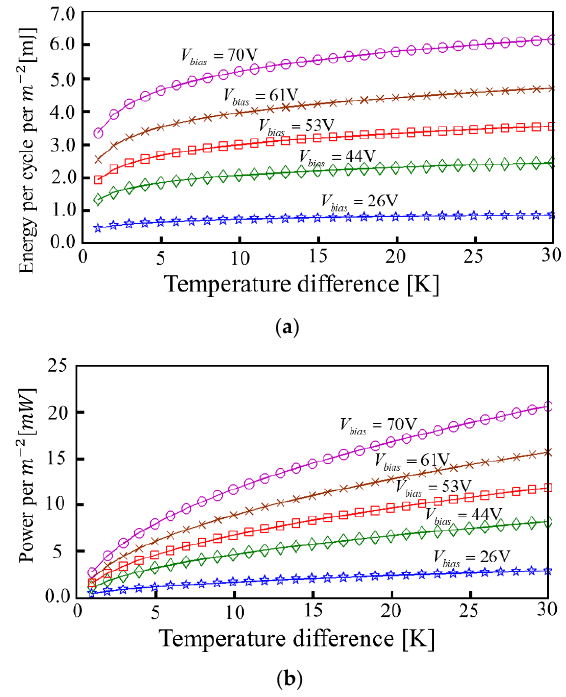
Figure 9. Relationship between the length ratio ( D /2 R w ) and frequency of the wheel at various temperature differences. ( a ) Frequency of the wheel with different length ratios (0 – 6) at various temperature differences ( Δ T = 0 – 30 K). ( b ) Required power of the engine with different length ratios (0 – 6) at different temperature differences ( Δ T = 0 – 30 K).